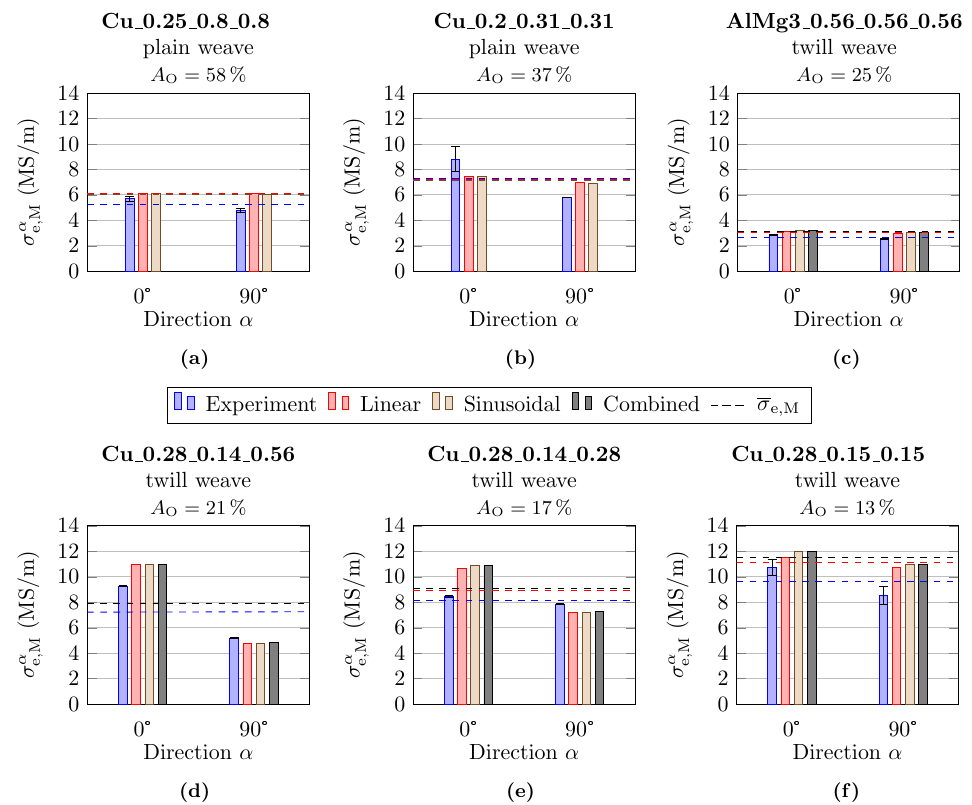
Figure 9. Comparison of the measured and analytically calculated specific electrical conductivity σ α of the investigated meshes depending on the direction α : ( a ) Cu_0.25_0.8_0.8, ( b ) Cu_0.2_0.31_0.31, ( c ) AlMg3_0.56_0.56_0.56, ( d ) Cu_0.28_0.14_0.56, ( e ) Cu_0.28_0.14_0.28 and ( f ) Cu_0.28_0.14_0.14. Decreasing the mesh size results in higher crimp and deformation of the warp